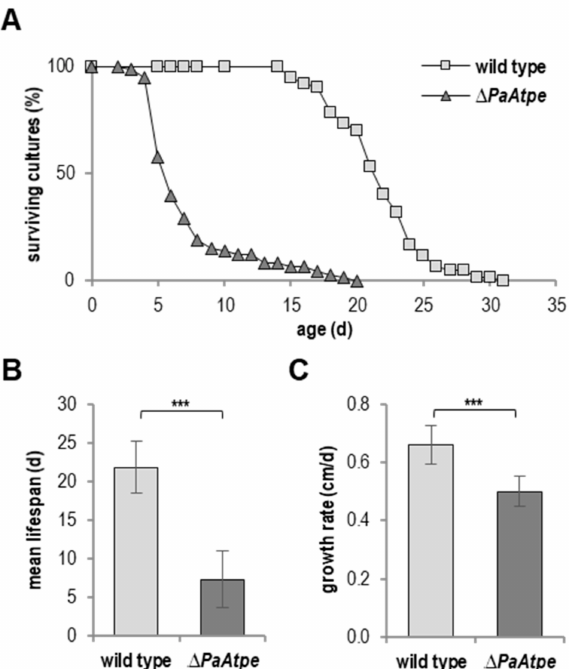
Figure 1. Deficiency in F 1 F o -ATP-synthase dimerization leads to lifespan and growth rate reduction. ( A ) Survival curve of P. anserina wild type ( n = 60) and ∆ PaAtpe ( n = 73; p = 1.5 × 10 − 25 ) grown on standard M2 medium. ( B ) Mean lifespan and ( C ) mean growth rates of cultures from ( A ). Error bars correspond to the standard deviation. The p -values of the survival curves were determined by SPSS with three different tests, and those for mean lifespan and growth rate by two-tailed Student’s t test. *** p <